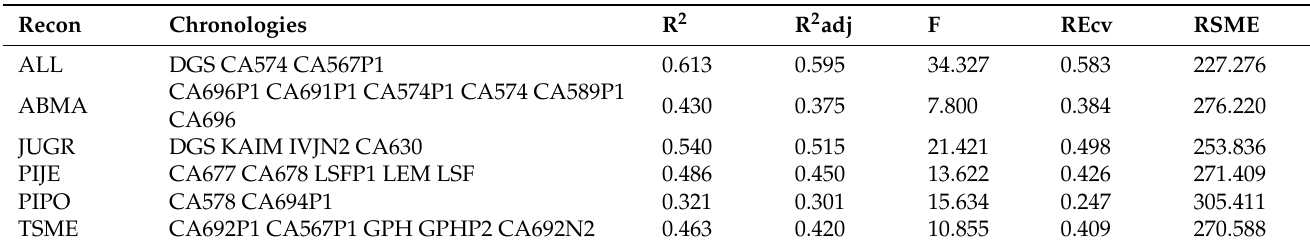
Table 2. Summary statistics 1 of species-specific reconstructions and from full-network (ALL) recon- struction of P12.